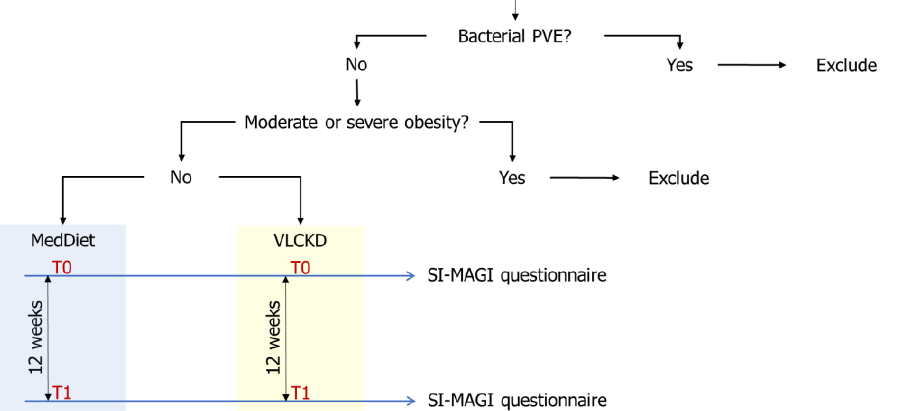
Figure 1. Protocol of the study. Patients with inflammatory prostate vesicle epididymitis who were overweight or mildly obese underwent a Mediterranean diet (MedDiet) or a very-low-calorie ketogenic diet (VLCKD) for at least 12 weeks. The Structured Interview on Male Accessory Gland Inflammation (SI-MAGI) questionnaire was administered to both groups before the start (T0) and after 12 weeks (T1) of the diet. Patients with bacterial PVE or moderate to severe obesity were excluded.